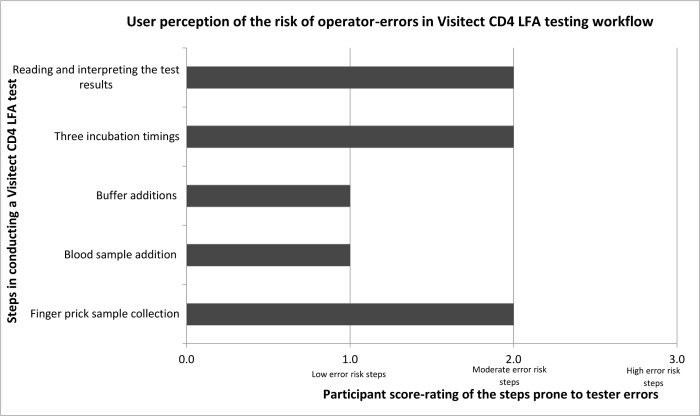
Perception of the risk of operator-errors in the Visitect CD4 LFA testing workflow among testers.